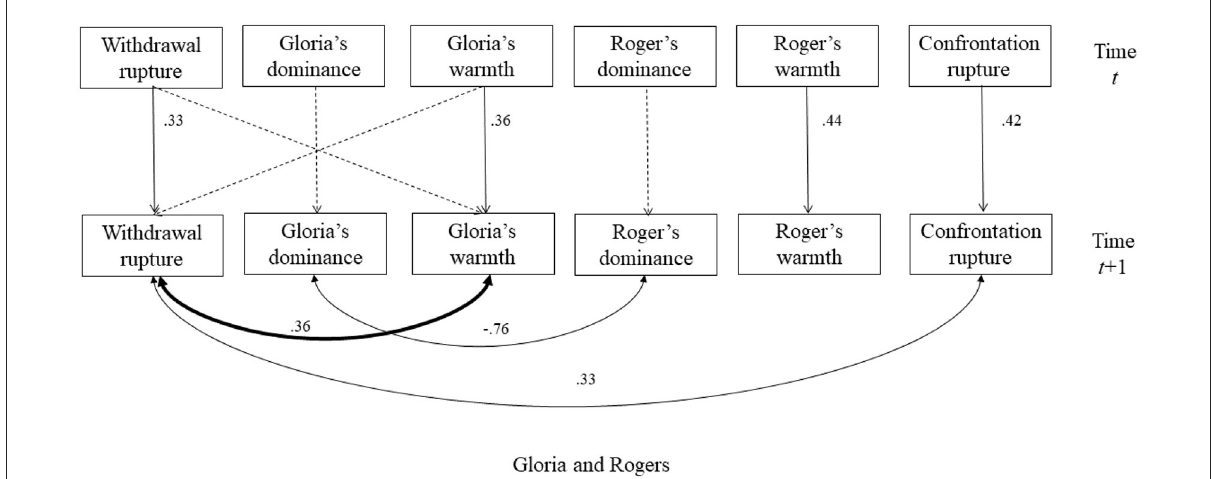
FIGURE2 The selected model for the session with Rogers. The dash lines indicated non-significant autoregressive or cross-lagged regressive pathways. Significant parameters were noted next to solid lines. The double-arrowed lines indicated covariance and the single-arrowed lines indicated autoregressive or cross-lagged regressive pathways. The significant relationships between interpersonal behaviors and ruptures were bolded.